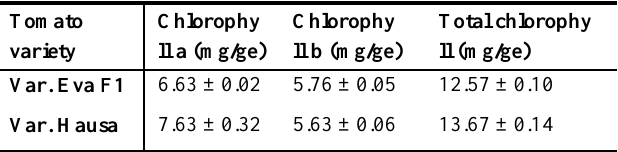
Table 3 : Chlorophyll content of extract of tomato leaf; var. Eva F1 and var. Hausa .